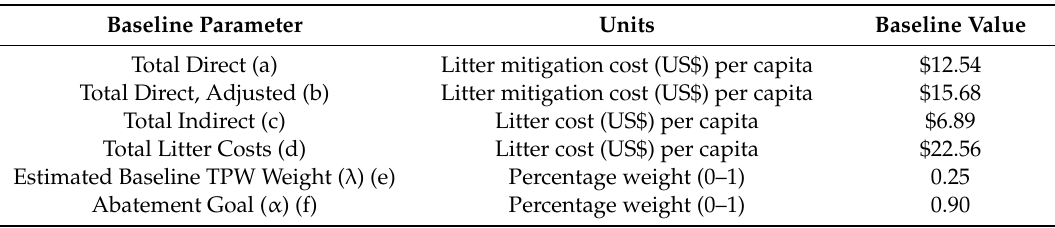
Table 1. Baseline Parameter Estimates for TPW Simulation Model in Major U.S. Cities (see previous discussion for